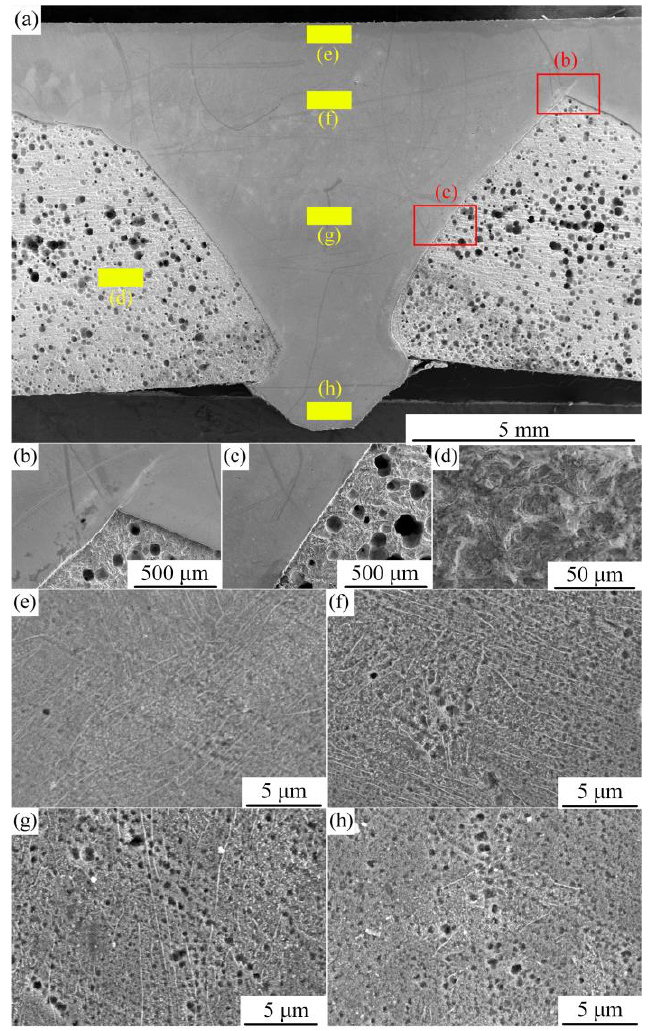
Figure 16. Corrosion morphology of di ff erent areas of the weld. ( a ) Macroscopic corrosion morphology of weld; ( b ) corrosion microstructure of zone b; ( c ) corrosion microstructure of zone c; ( d ) corrosion microstructure of zone d; ( e ) corrosion microstructure of zone e; ( f ) corrosion microstructure of zone f; ( g ) corrosion microstructure of zone g; ( h ) Corrosion microstructure of zone h.